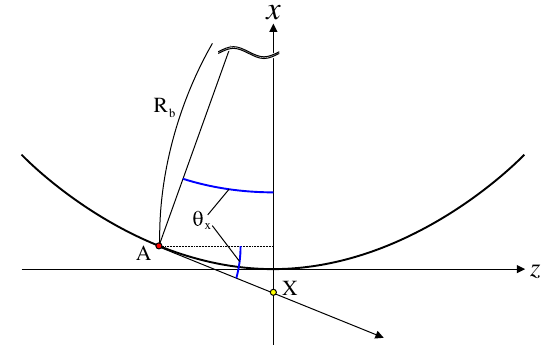
FIG. 2. Schematic illustration of emission of radiation from an electron (red circle) moving along the circular orbit indicated by the solid black line. The coordinate X denotes the horizontal position of a photon (yellow circle) at the longitudinal origin, which is emitted from the electron when it passes the point